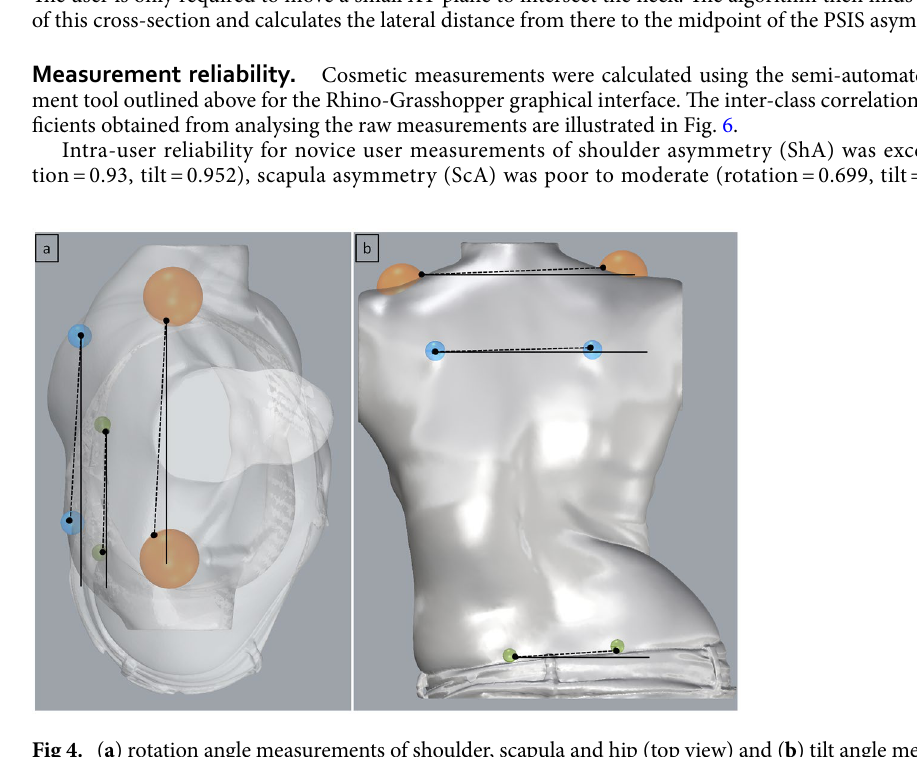
Fig 4. ( a ) rotation angle measurements of shoulder, scapula and hip (top view) and ( b ) tilt angle measurements of shoulder, scapula and hip (back